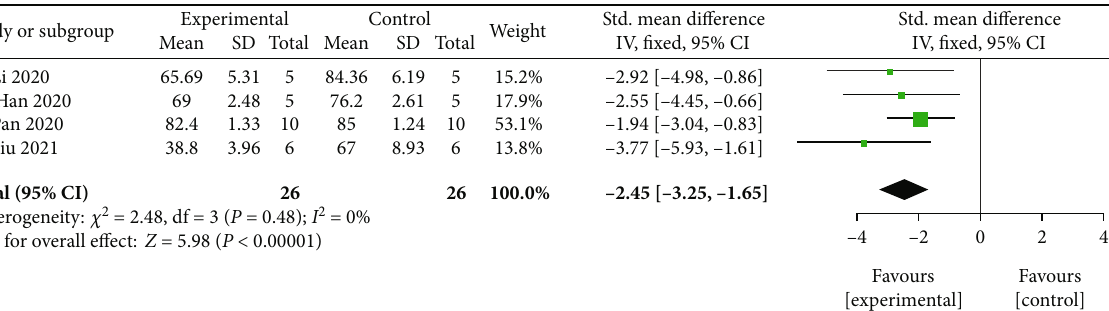
Std. mean difference IV, fixed, 95% CI